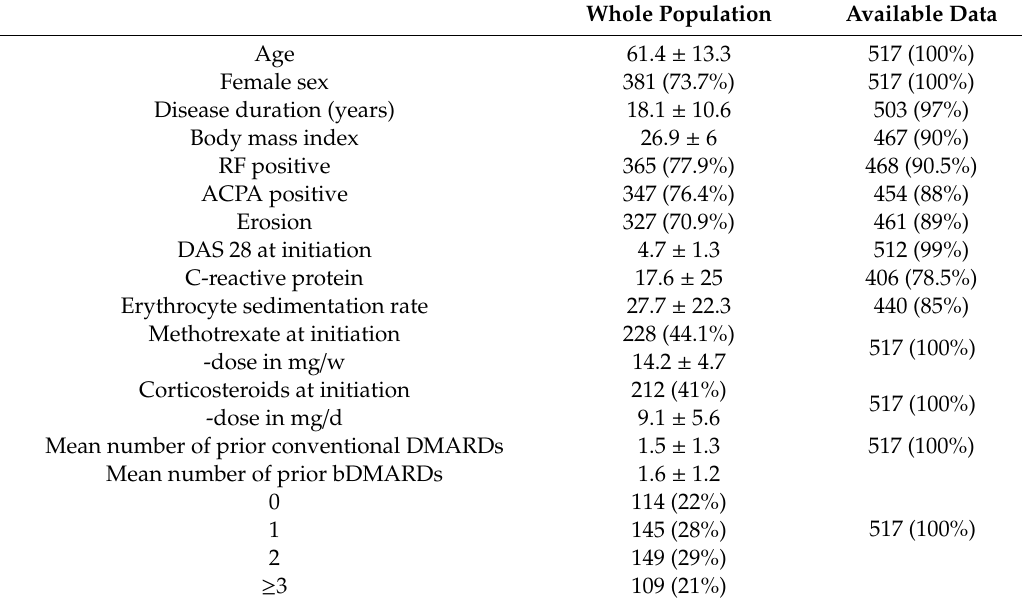
Figure 1. Flow chart of the study population. Table 1. Baseline characteristics of the study population ( n = 517).